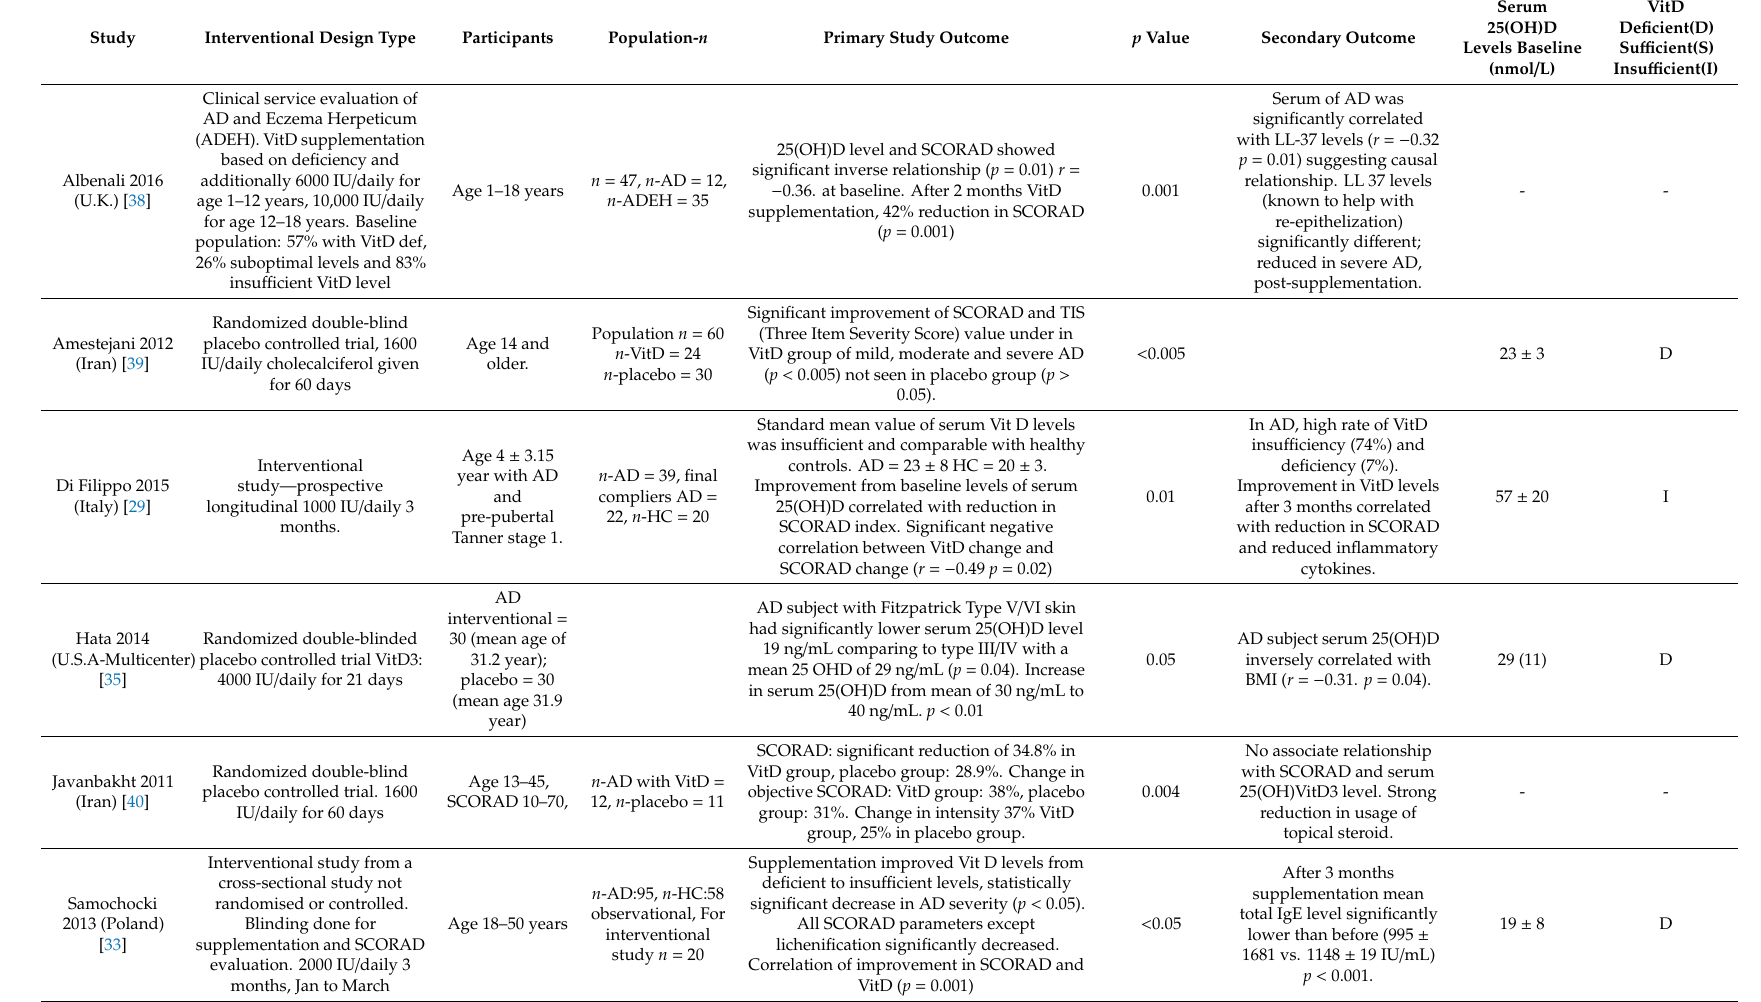
Table 3. Interventional studies of vitamin D supplementation in atopic